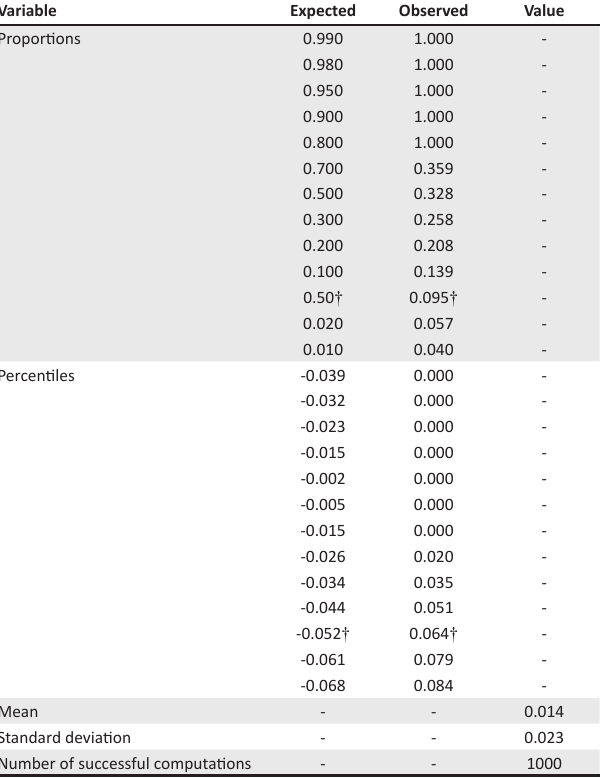
TABLE 9: Mean, standard deviation, critical value of Root Mean Square Error of Approximation fit index across 1000 draws. Variable